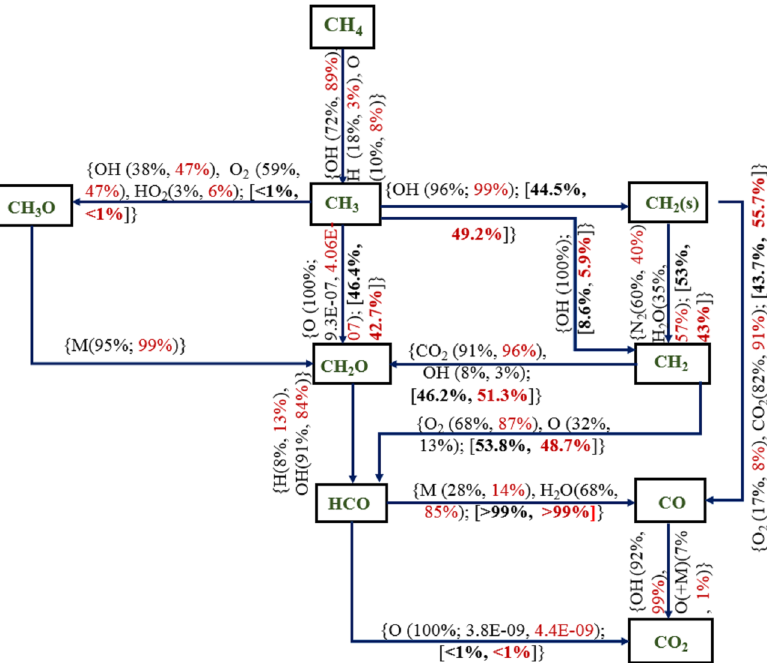
Figure 17. Methane–air combustion with no dilution (values in black color) and 20% dilution (values in red color) at 393 K and P = 1 atm for DRM-22 mechanism with a residence time of 0.5 s and the values within the square bracket represents the branching percentage of the particular reaction from the precursor intermediate